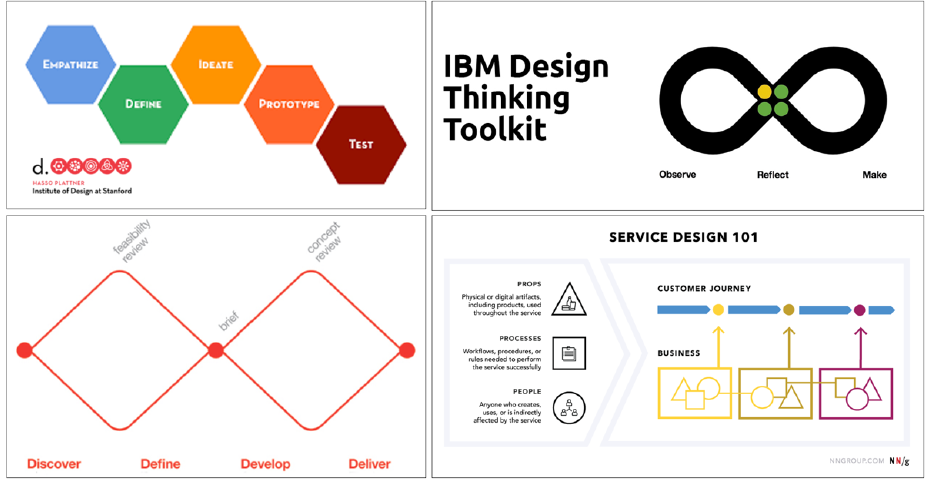
Figure 1. Examples of some human-centred design frameworks. From the top-left: design thinking, Stanford; IBM Design Thinking; double-diamond British Design Council; service design 101. The position of this article is that DT can be an agent for museum digital